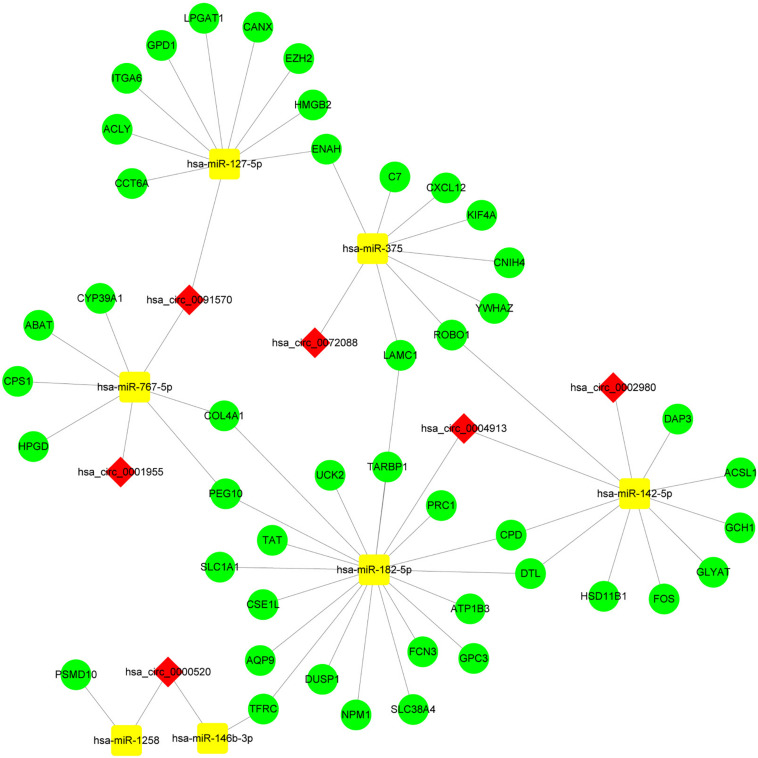
Construction of the circRNA-miRNA-mRNA network based on 45 DEmRNAs related to macrophages. The network was constructed after taking the intersection of DEcircRNA-DEmiRNA pairs and DEmiRNA-macrophage-related DEmRNA pairs. The red diamond, yellow rectangle, and light green ellipse indicate circRNA, miRNA, and mRNA, respectively.